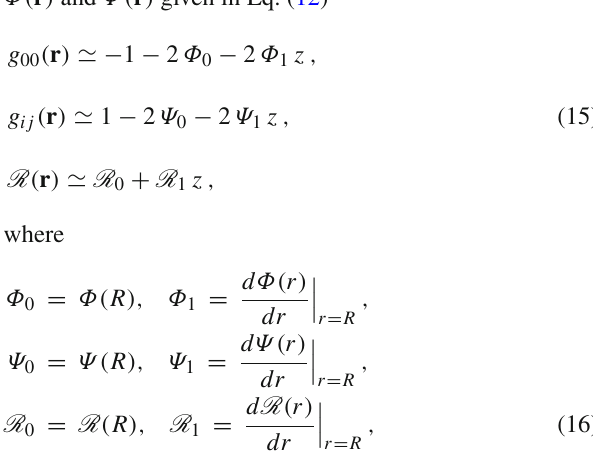
R along the z direction by using the gravitational potentials Φ( r ) and Ψ ( r ) given in Eq.